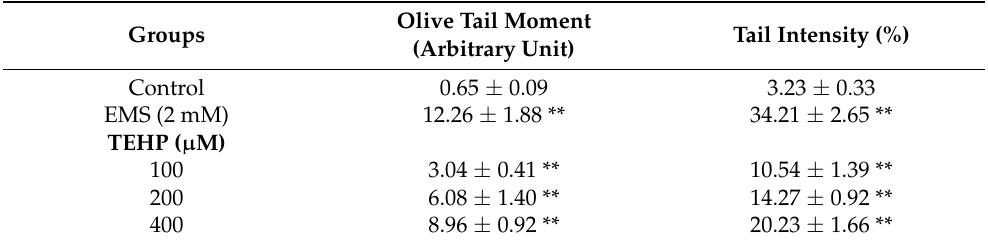
Table 1. TEHP-induced DNA damage in HepG2 cells, analyzed using different parameters of alkaline comet assay.